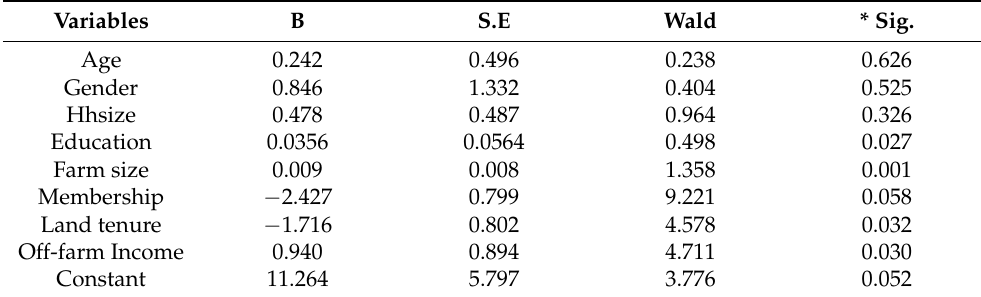
Table 6. Logit model